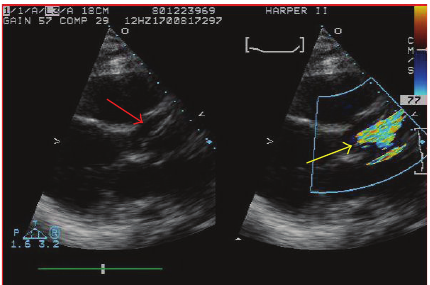
Figure 4: After echocardiographic guidance the Impella inlet is properly positioned above the aortic valve (red arrow). Supravalvu- lar turbulence is indicated by the yellow